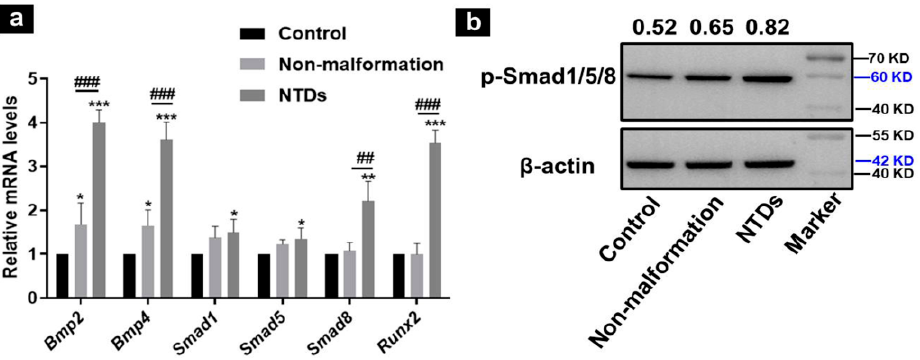
Figure 2. Activation of the BMP/Smad signaling pathway in embryonic brain tissues at E 13.5. ( a ) mRNA levels of Bmp2, Bmp4, Smad1/5/8 and Runx2 were analyzed with qRT-PCR. ( b ) The phosphorylation of Smad1/5/8 was determined with Western blotting. β -actin was used as loading control. Data are shown as mean ± SD (n = 3; * p < 0.05, ** p < 0.01 and *** p < 0.001 vs. control group; ## p < 0.01, ### p < 0.001 vs. the nonmalformation group).